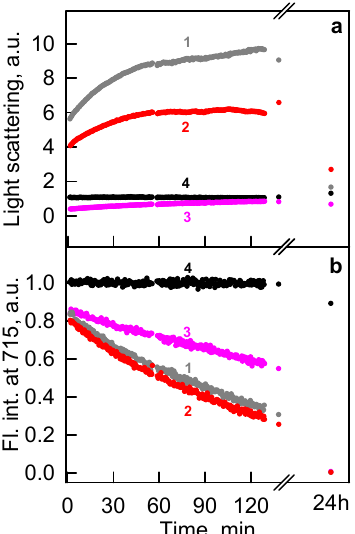
Figure 8. Effect of ATP on the kinetics of GTC-induced unfolding of iRFP713 in the holoform. ( a ) Changes in the light scattering. ( b ) Changes in the parameter A = I 320 / I 365 at an excitation wavelength of 295 nm. Curves 1, 2, and 3: unfolding induced by 1.0 M GTC in the presence of 0, 10, and 100 mM Mg-ATP; Curve 4: control, 0 M GTC, 0 mM Mg-ATP.